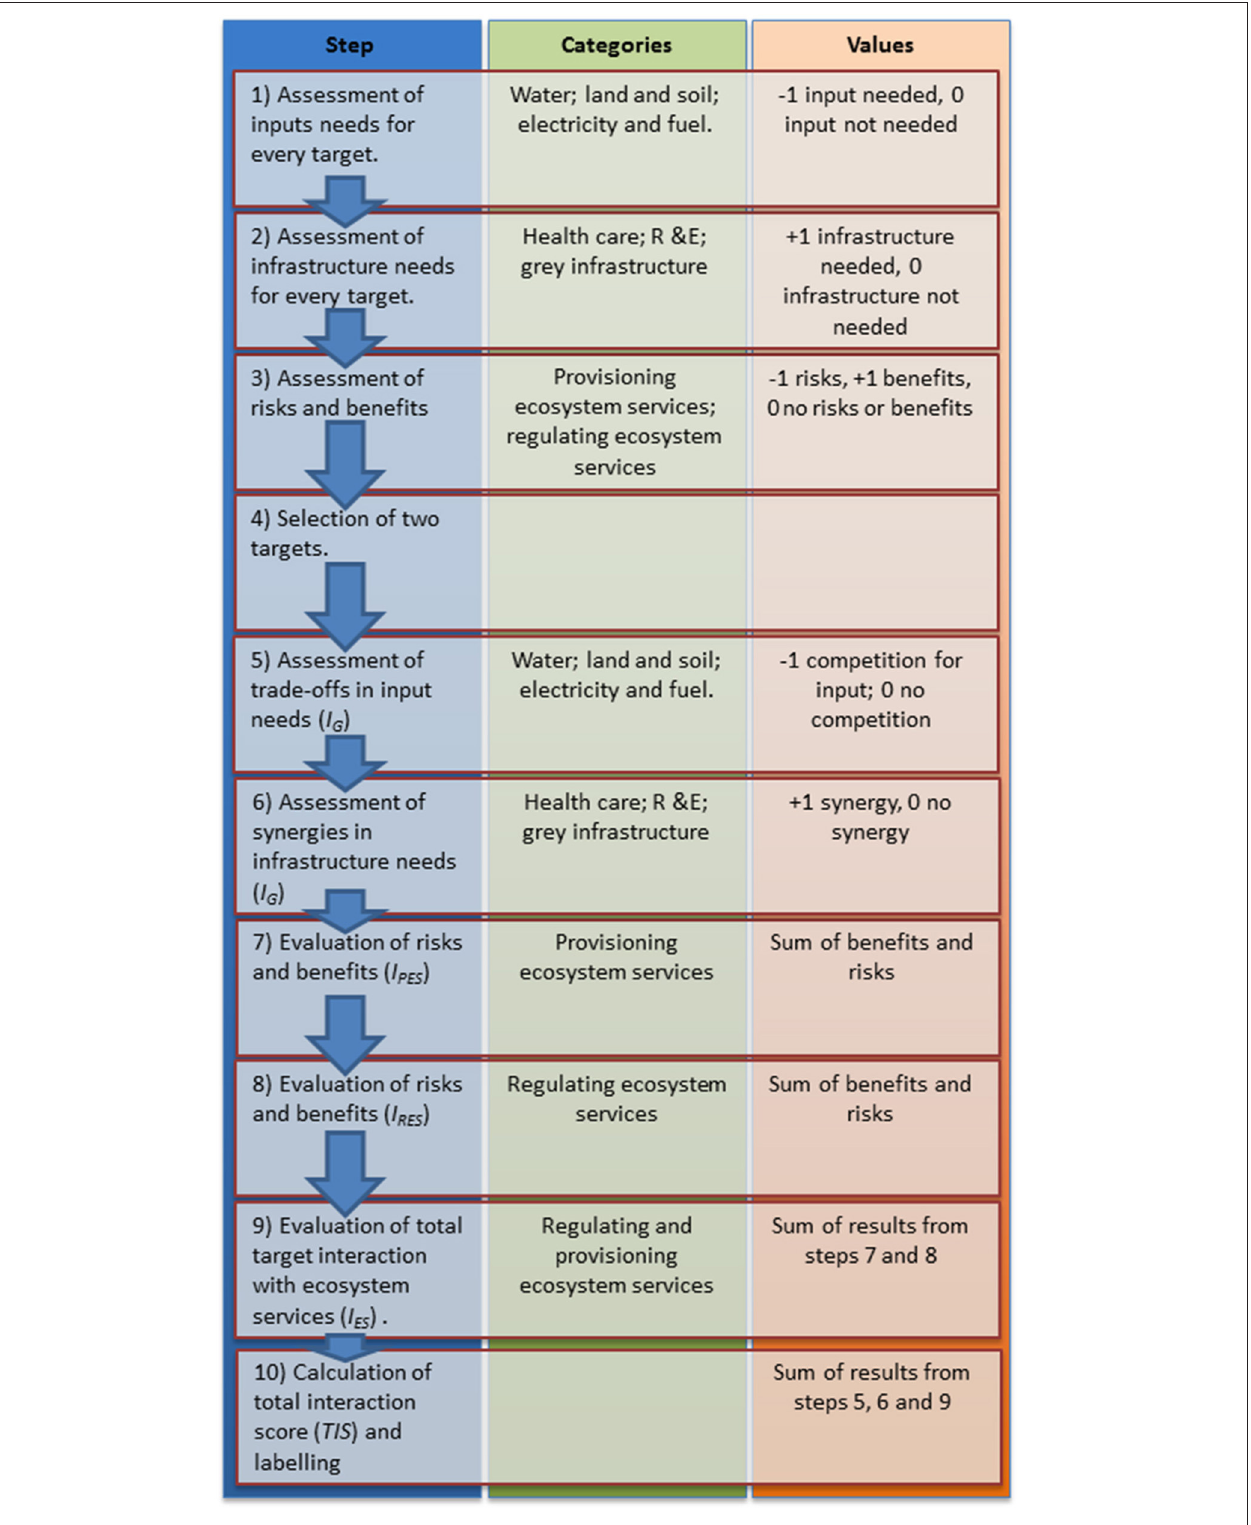
FIGURE 1 | Steps for assessment of synergies and trade-offs between two SDG targets.